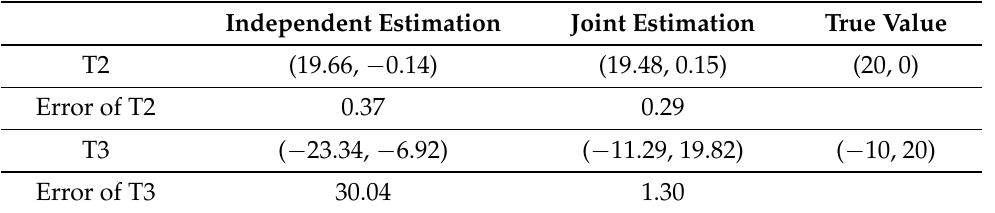
Table 3. The results using the joint estimation